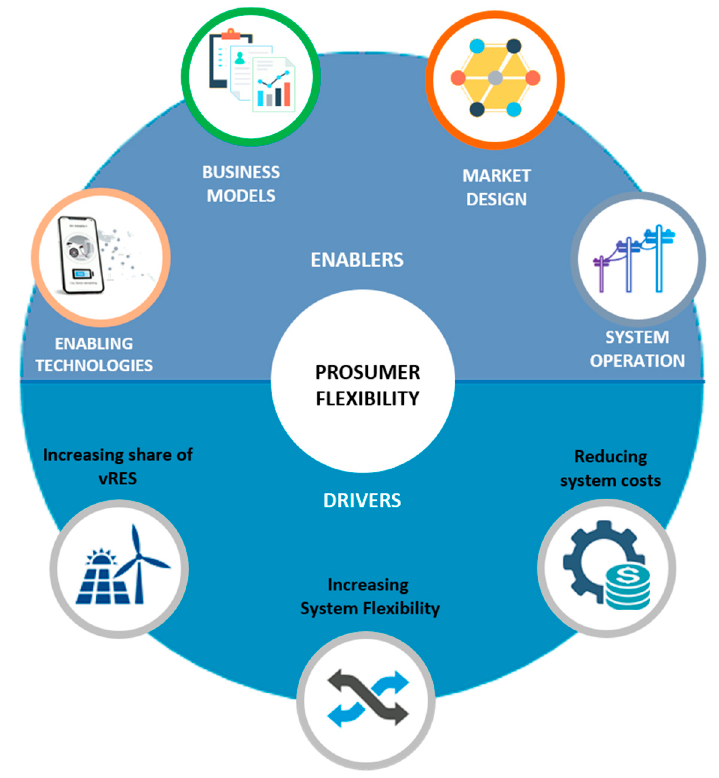
Figure 1. Changing energy landscape.